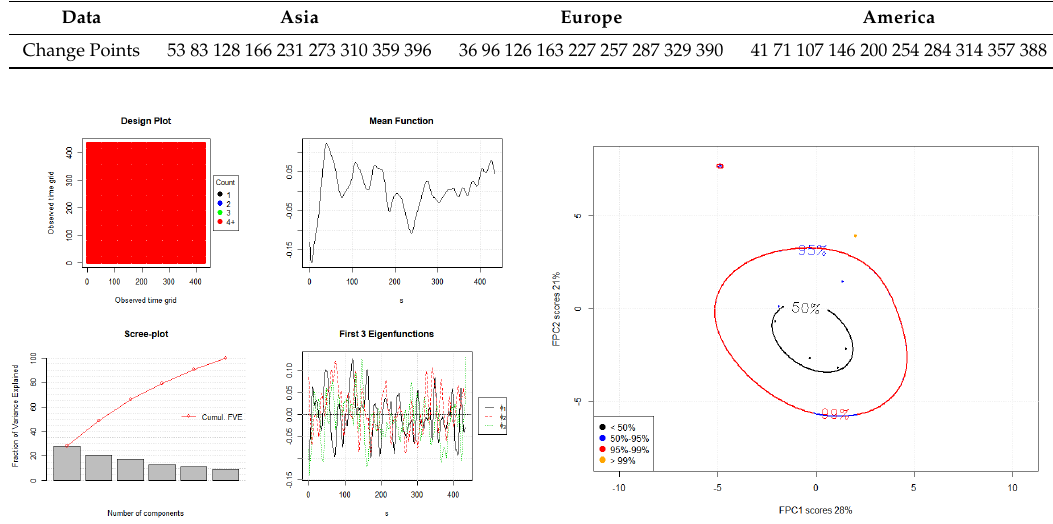
Table 15. Change point detection with the James, Zhang, and Matteson (2019) nonparametric multiple change point analysis of real exchange currency data (1/3/2013 to 10/6/2014). Data